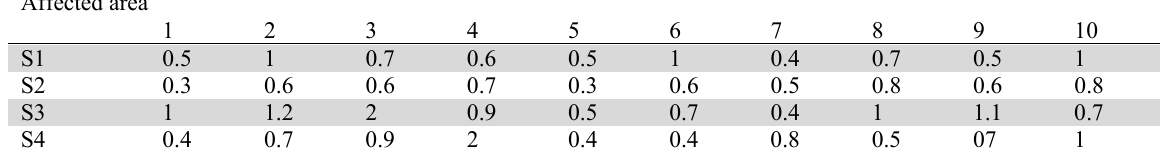
Maximum time related to rescue operation under each scenario and for two time periods Affected area